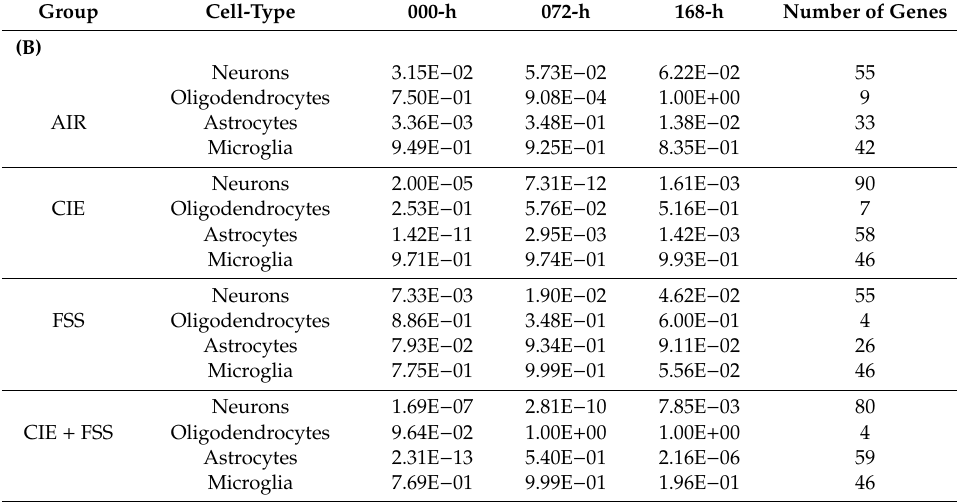
Table S1: Enrichment of di ff erentially expressed genes for biological categories that are uniquely altered within an individual behavioral group (CTL, CIE, FSS, and CIE + FSS) and are consistently overrepresented across each of the three timepoints (0 h, 72 h, and 168 h). Table S2: List of 292 statistically significant genes (padj < 0.05) assigned to 14 clusters following a hierarchical cluster analysis using R package